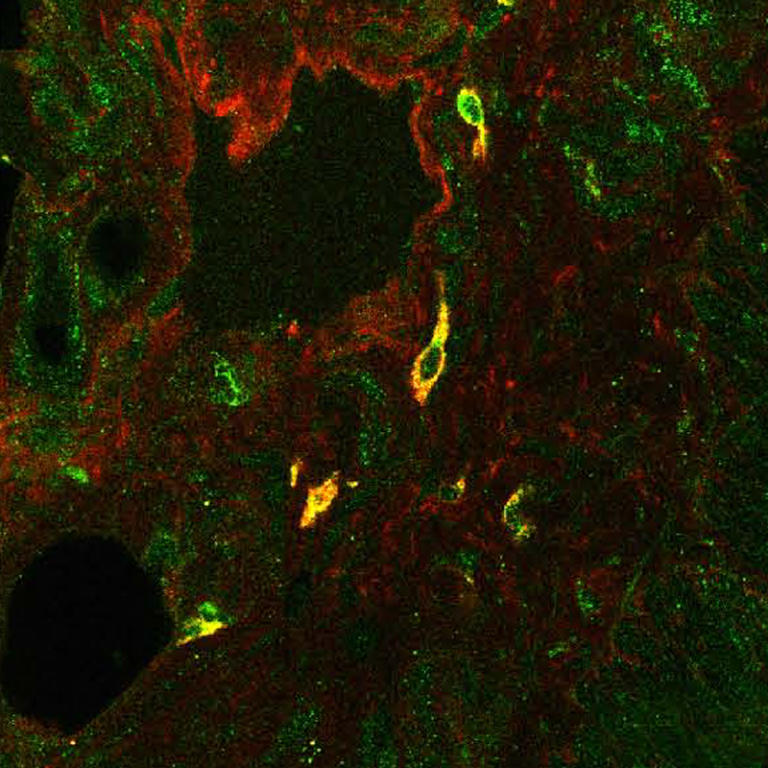
Cyclooxygenase-2 (green immunofluorescence) and the macrophage marker ED2 (red immunofluorescence) in rat lung at the onset of bacterial lipopolysaccharide-induced fever (photo: Jordi Serrats).